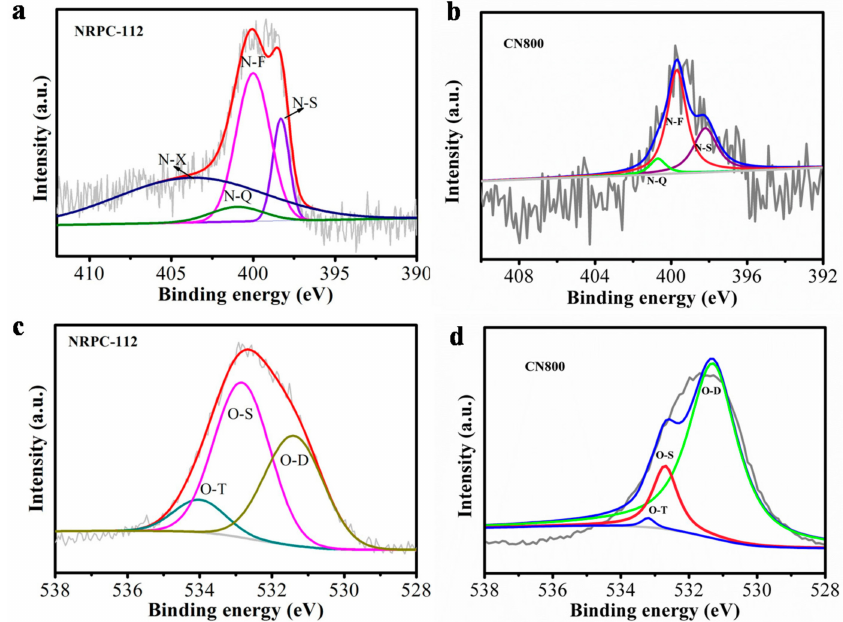
Figure 8. XPS spectra of the as-prepared carbon samples ( a ) N 1s of NRPC-112, ( b ) N 1s of CN800, ( c ) O 1s of NRPC-112, ( d ) O 1s of